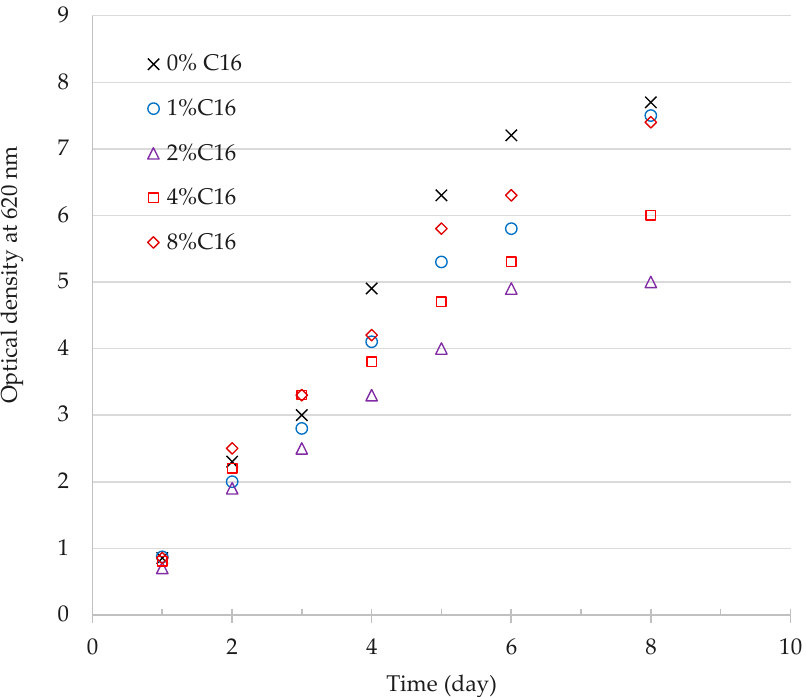
Figure 3. Chemolithotrophic growth of C. necator with different volume % of n-hexadecane (C 16 H 34 ). Average ODs of duplicated bottle cultures are presented with the deviation less than 5%. Error bars are not plotted for clearness.